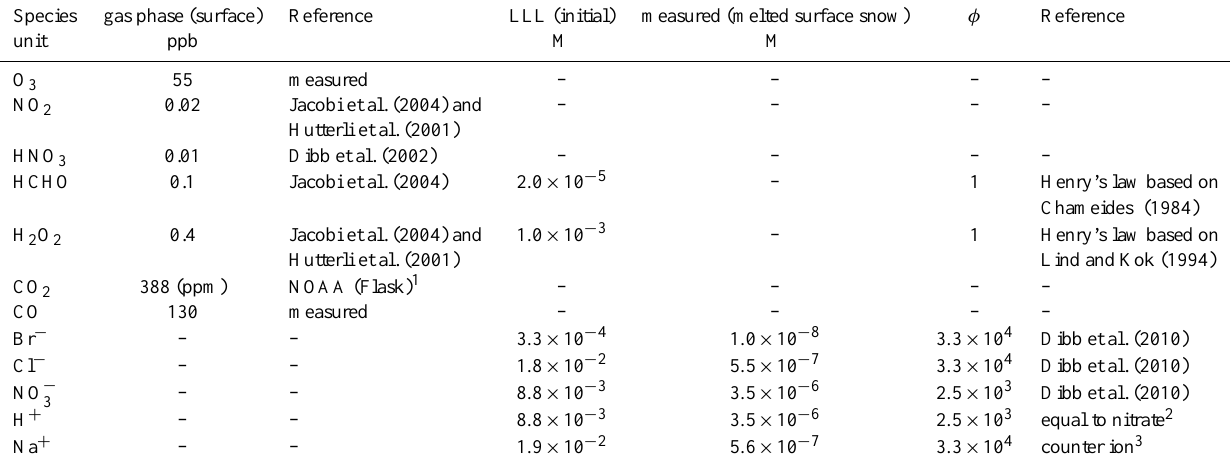
Table 2. Initial gas and liquid-like layer (LLL) concentrations for model runs conducted based measurements taken in June 2008 as well as previous measurements at Summit, Greenland.